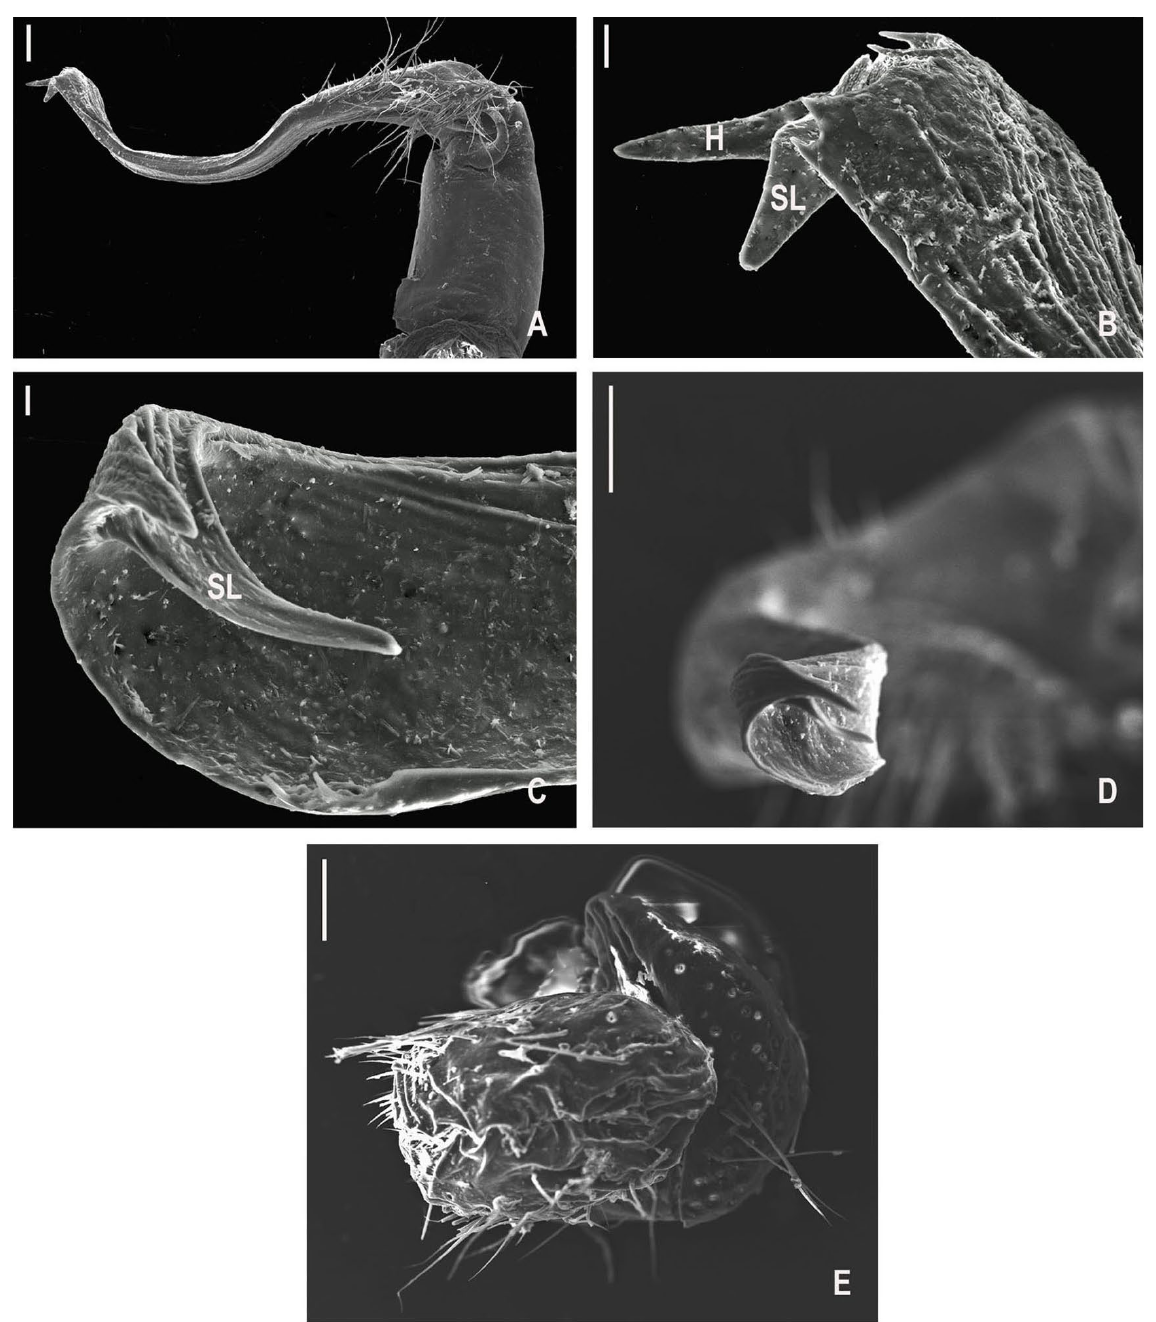
Fig. 4. Levizonus distinctus Mikhaljova, 1990, ♂♂, ♀ (FSCB 11983, 11984). A . Gonopod, mesal view, unnaturally curved. B . Gonopod apex, mesal view, slightly rotated around its axis. C–D . Gonopod apex, ventral view, in somewhat different angles. E . Vulva, mesal view. Scale bars: A, D–E = 100 μm; B = 20 μm; C = 10